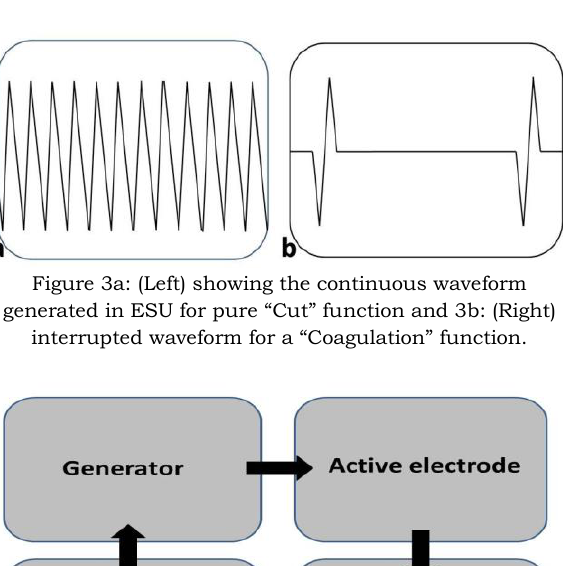
Figure 2: Schematic depiction of various applications of radiofrequency waves along the spectrum.